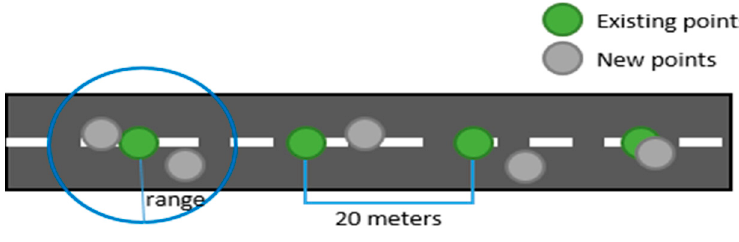
Figure 2. The map visualization process.